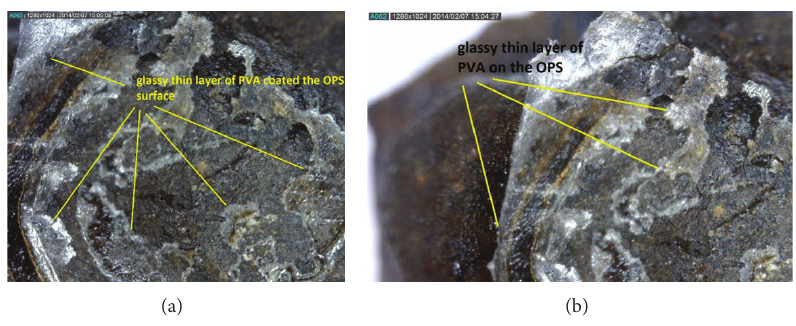
Figure 7: OPS aggregates soaked in polyvinyl alcohol.